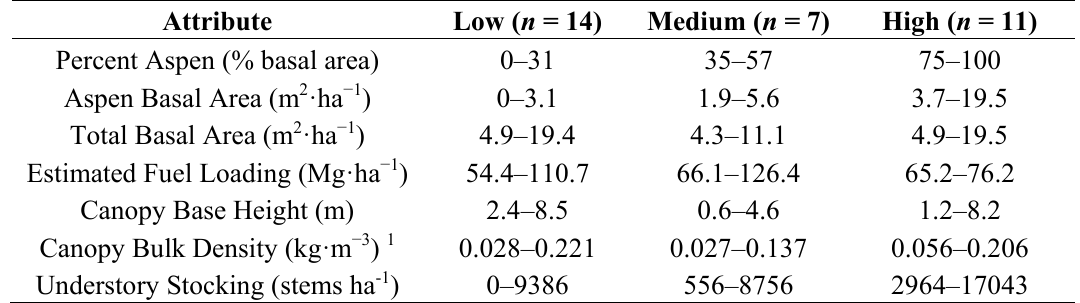
Table 1. Range of stand and site attributes for the study plots classified by aspen dominance (percent aspen basal area): low, 0%–33%; medium, 34%–66%; high,